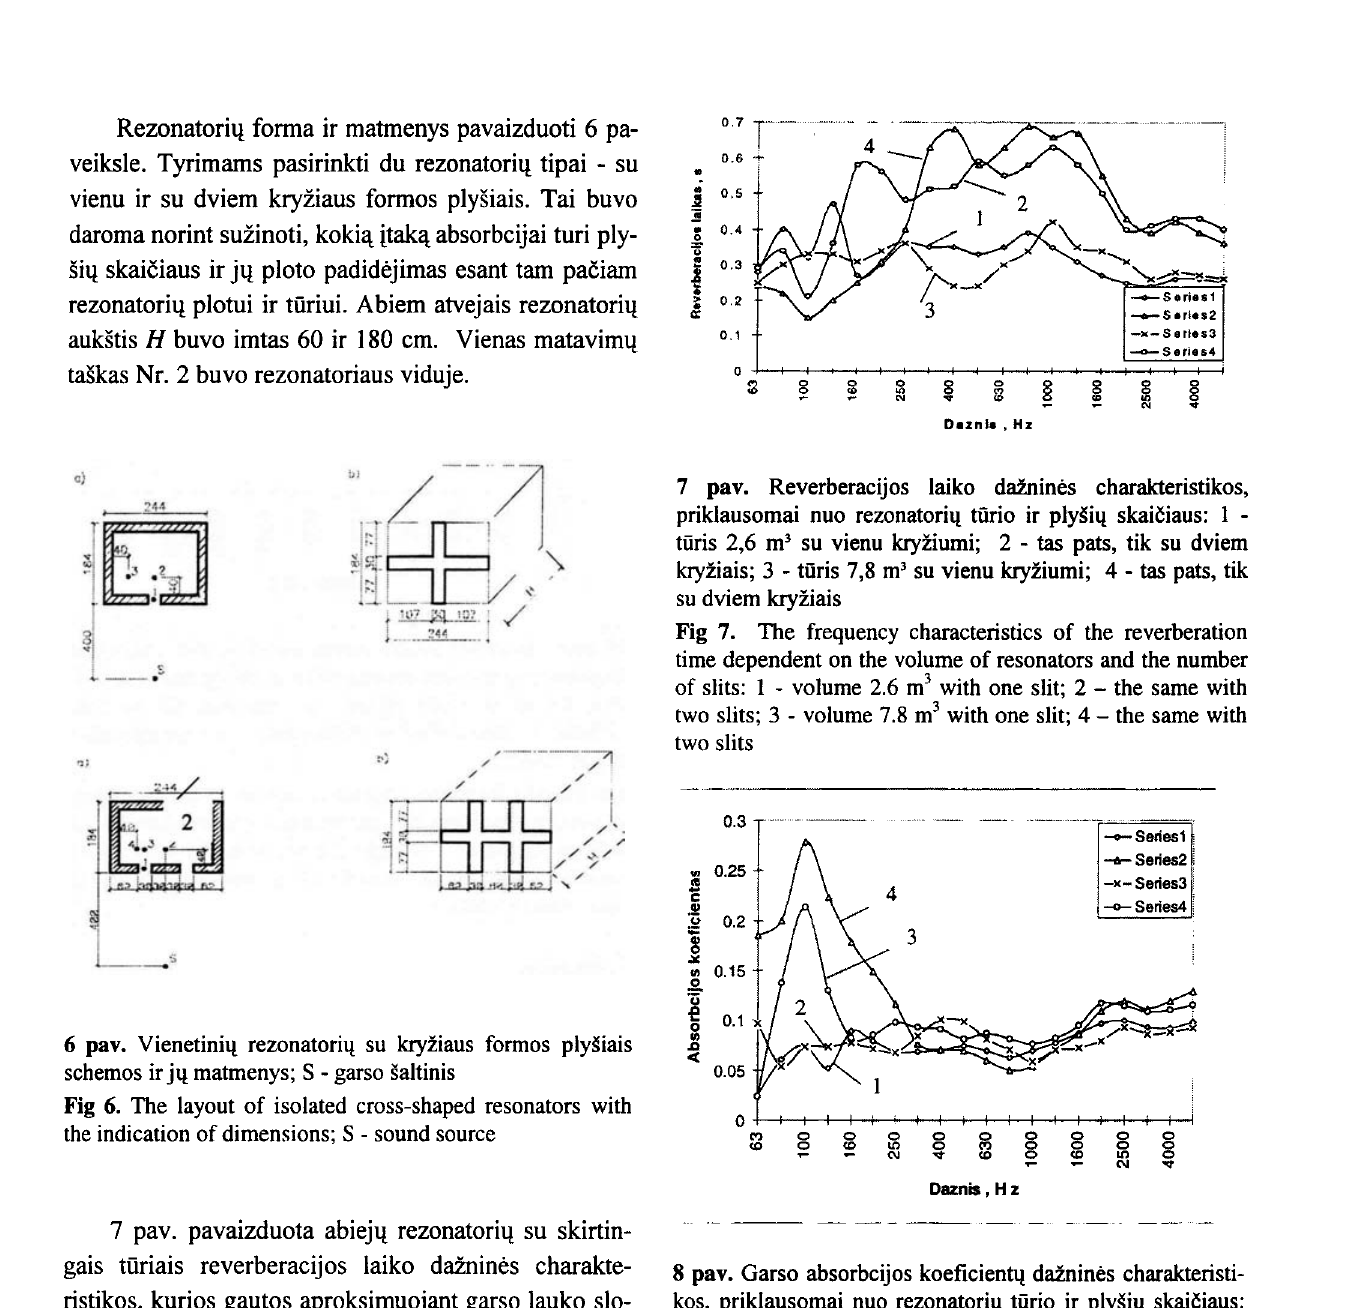
Fig 8. The frequency characteristics of the sound absorption coefficients dependent on the volume of resonators and the number of slits: 1 - volume 2.6 m 3 with one slit; 2 - the same with two slits; 3 - volume 7.8 m 3 with one slit; 4- the same with two slits Garso absorbcijos koeficientai ir garso absorbcija buvo apskaiciuoti is ismatuoto reverberacijos